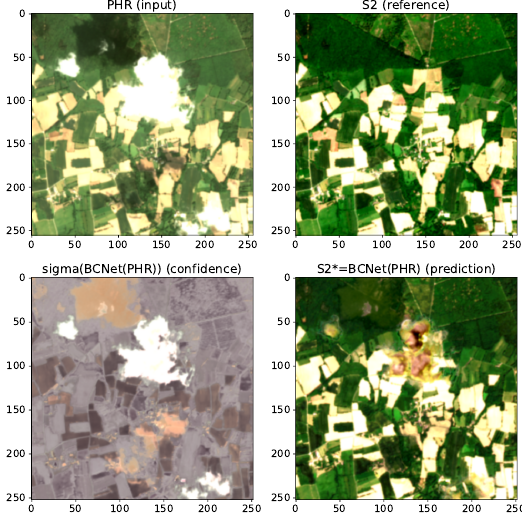
Figure 18. Pleiades input, Sentinel-2 reference, BCNet confidence and prediction for a patch of the Bretagne2 dataset.